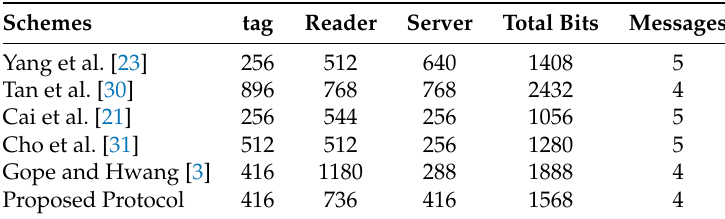
Table 6. Communication Cost of Proposed and other Protocols.